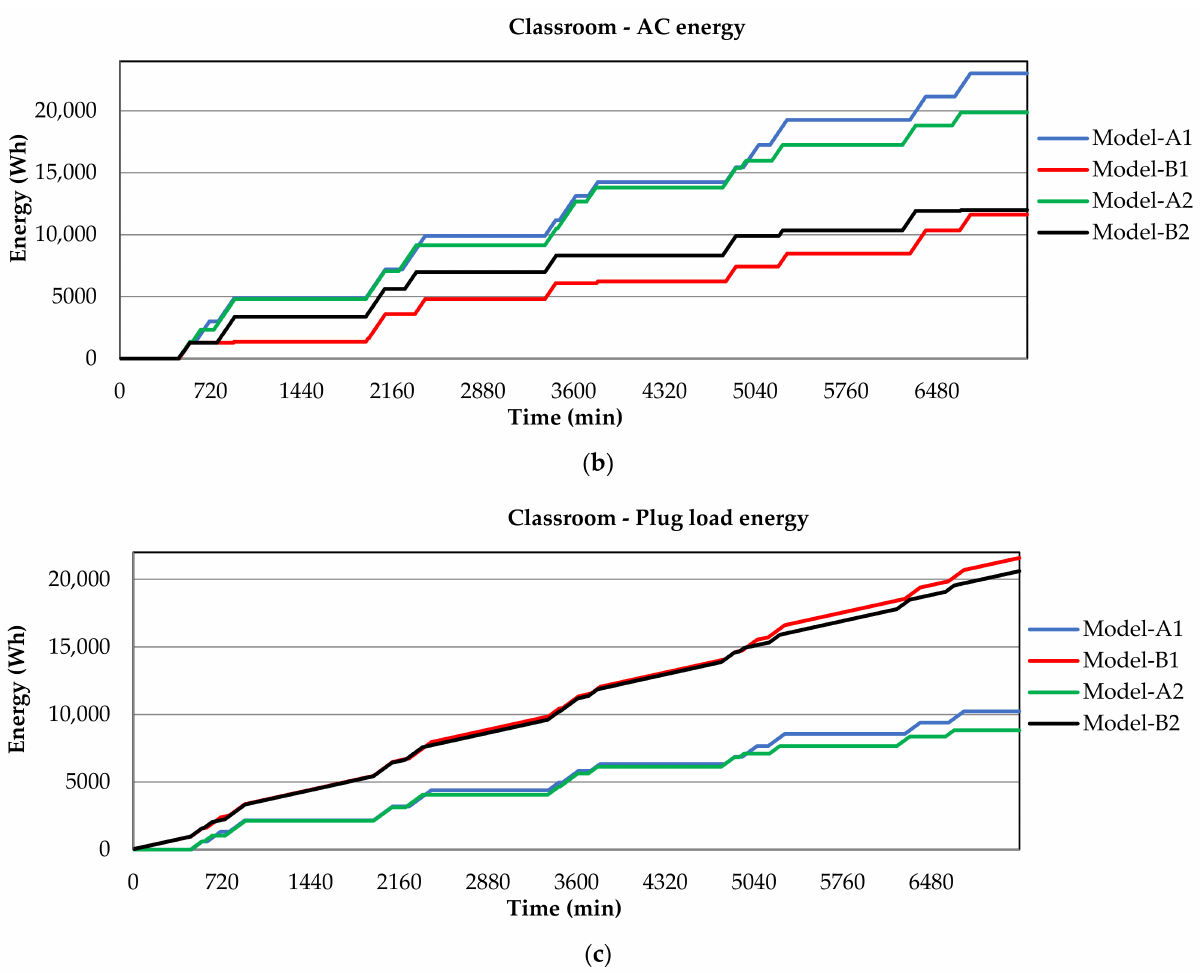
Figure 14. Profile of energy consumption in the Classroom: ( a ) lighting energy; ( b ) AC energy; ( c ) plug load